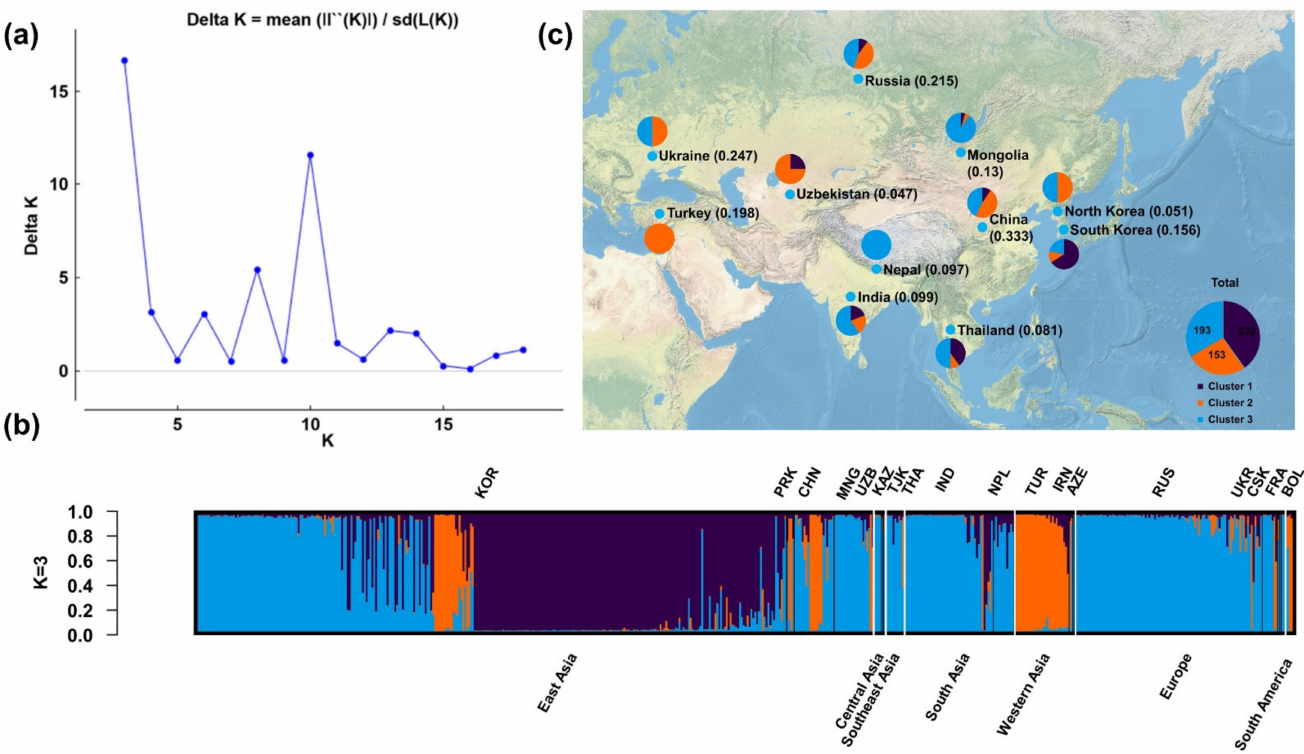
Figure 1. Population structural analysis results. ( a ) Determination of the optimal number of subpopulations (K) according to the values of ∆ K calculated by the Structural Harvester program. ( b ) Corresponding population structure diagram and ( c ) geographical distribution for K =